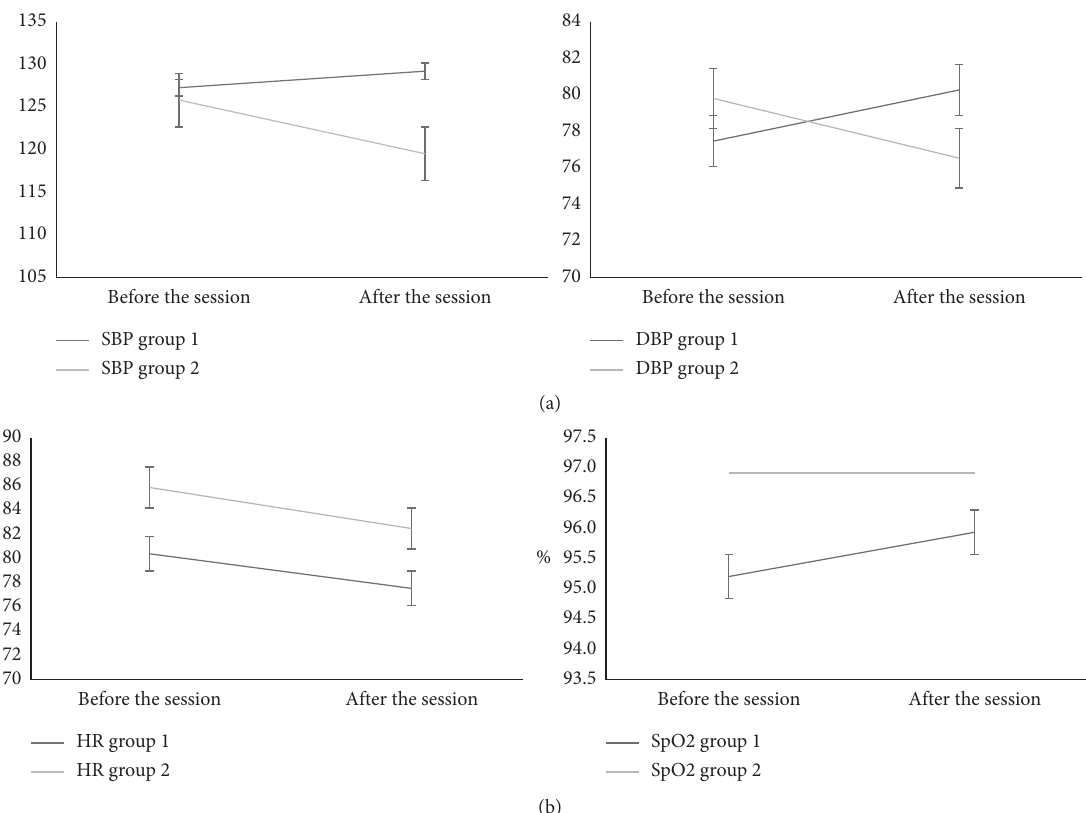
Figure 2: Variation between the medians of hemodynamic function before and after the intervention in both groups. SBP � systolic blood pressure; DBP � diastolic blood pressure; HR � heart rate; SpO 2 � peripheral oxygen saturation; G1 � Group 1; G2 � Group